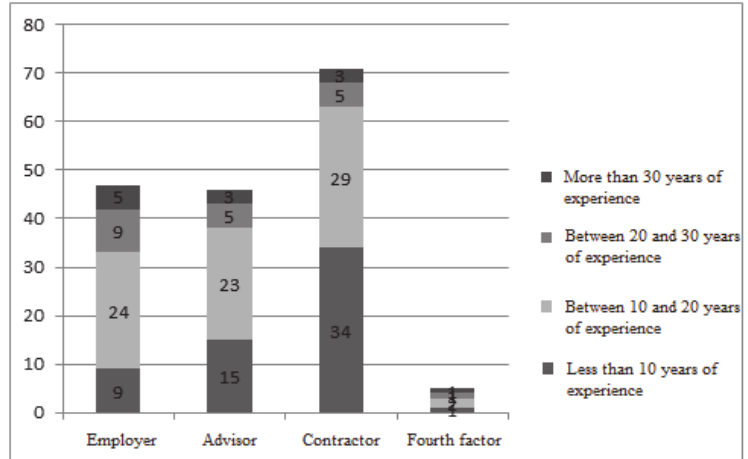
Fig. 1. Abundance according to executive organ and